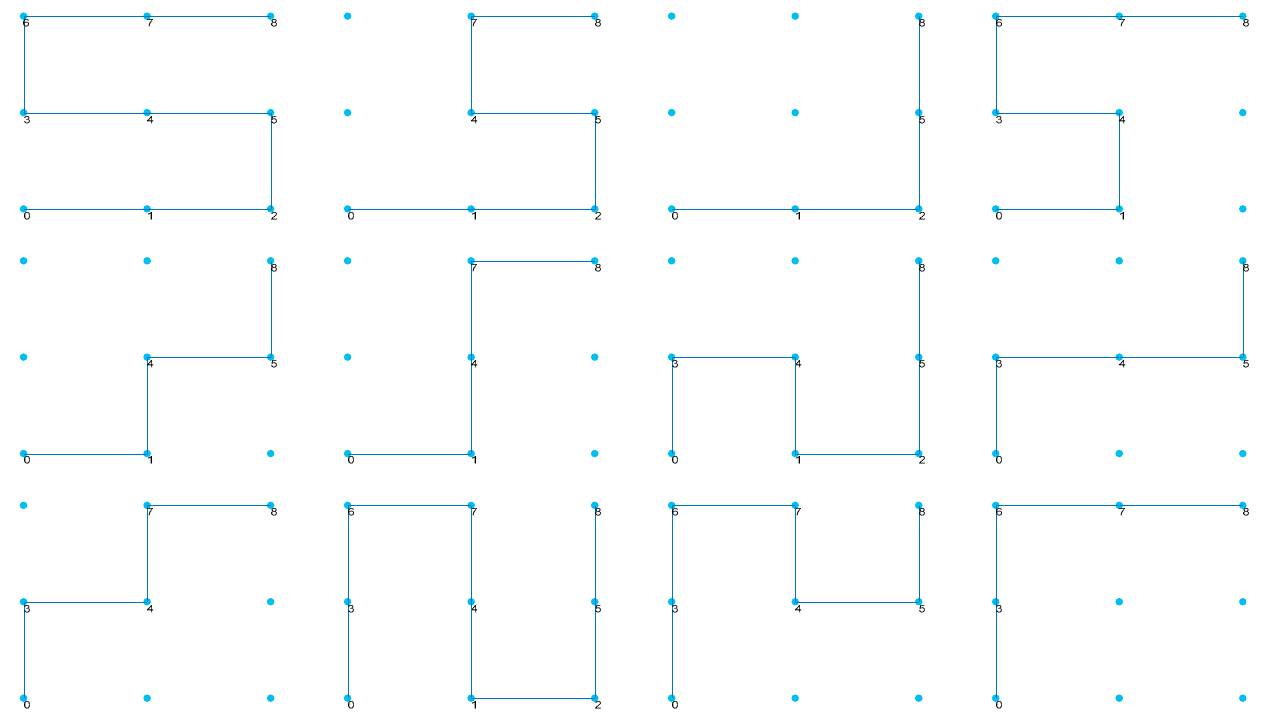
Figure 7. All possible paths between Node 8 and Node 0 of a 3 × 3 lattice converter (4. 4. 4.